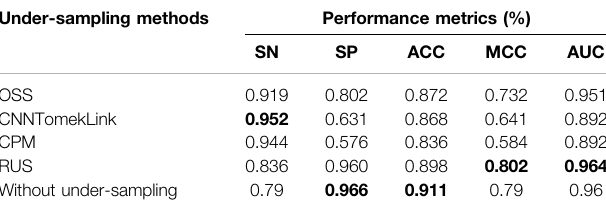
TABLE 5 | Classi fi cation results of different under-sampling methods on the train dataset. Feature extration methods